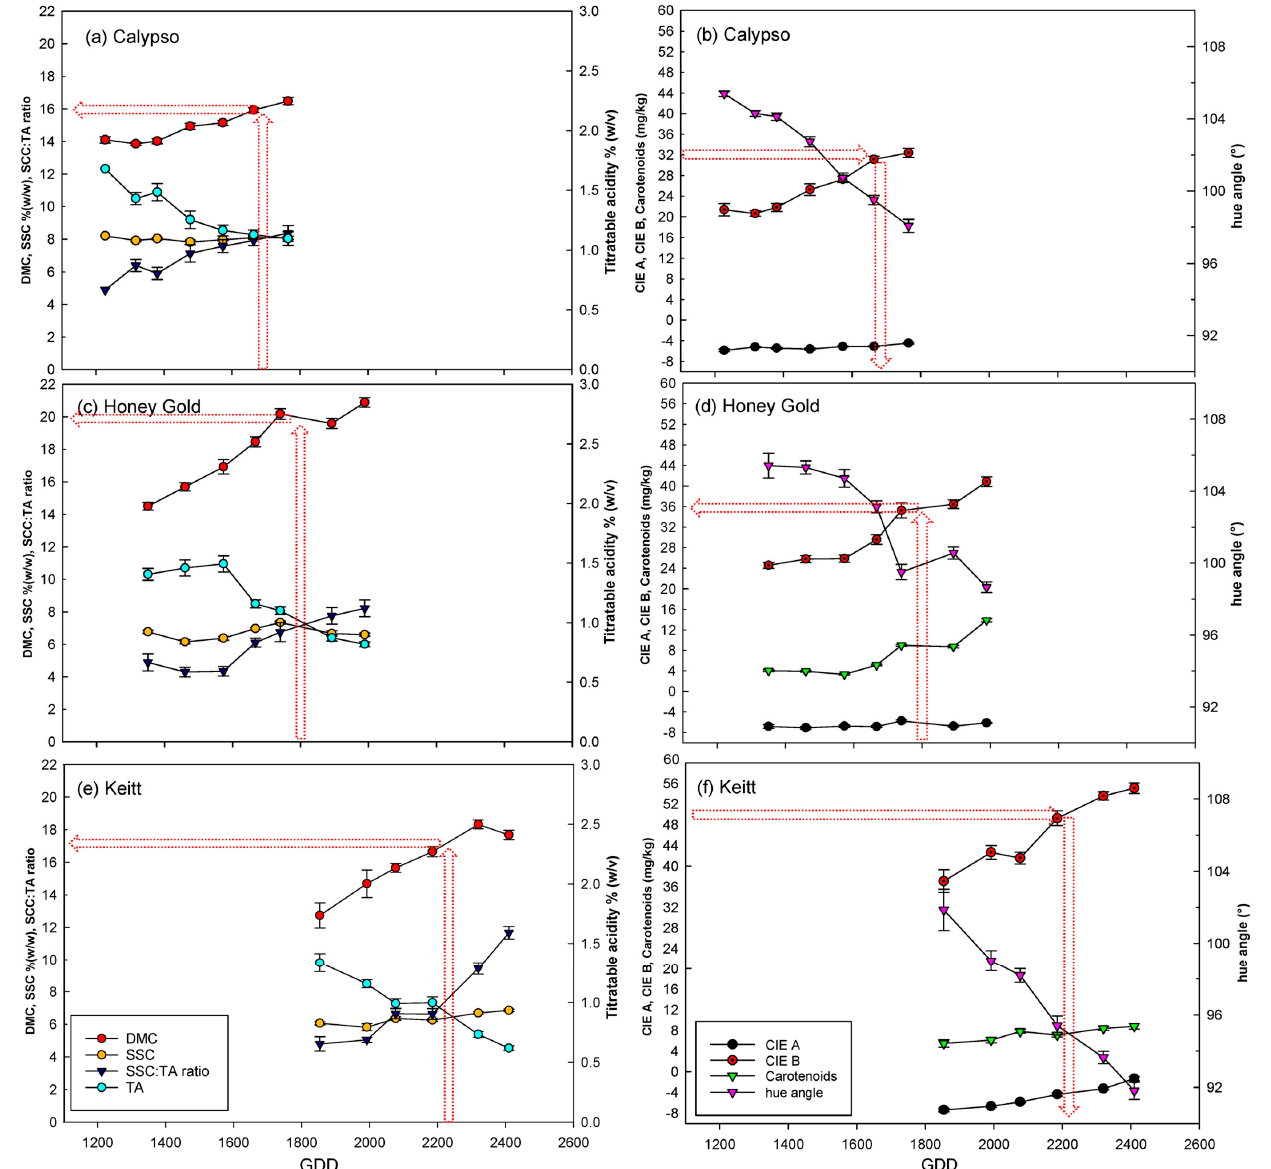
Figure 4. Time course from stone hardening of fruit attributes (for populations 3, 5 and 7 of Table A1, shown in top ( a , b ), middle ( c , d ) and bottom ( e , f ) panels, respectively). Left panels: DMC, SSC, SSC:TA ratio and TA. Right panels: flesh colour CIE AB values and total carotenoids (mg/kg); Data presented as mean with associated standard error ( n = 10 to 20 fruit for Calypso, 5 to 10 fruit for Honey Gold and Keitt). For Calypso and Kensington Pride, red lines are drawn from the CIE B value associated with harvest maturity, i.e., 32 for Calypso and Kensington Pride and 51 for Keitt, to the associated GDD (lright panel), and from this GDD value to the associated DMC value (left panel). For Honey Gold, the red line is drawn from the recommended GDD of 1800 to the associated B and DMC values. X axis is given in heat units (GDD) estimated from asparagus stage of flowering using Tb 12 °C and TB 32 °C.